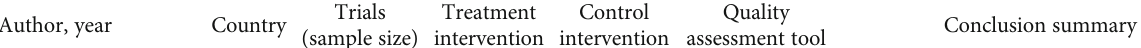
Table 2: Characteristics of the included